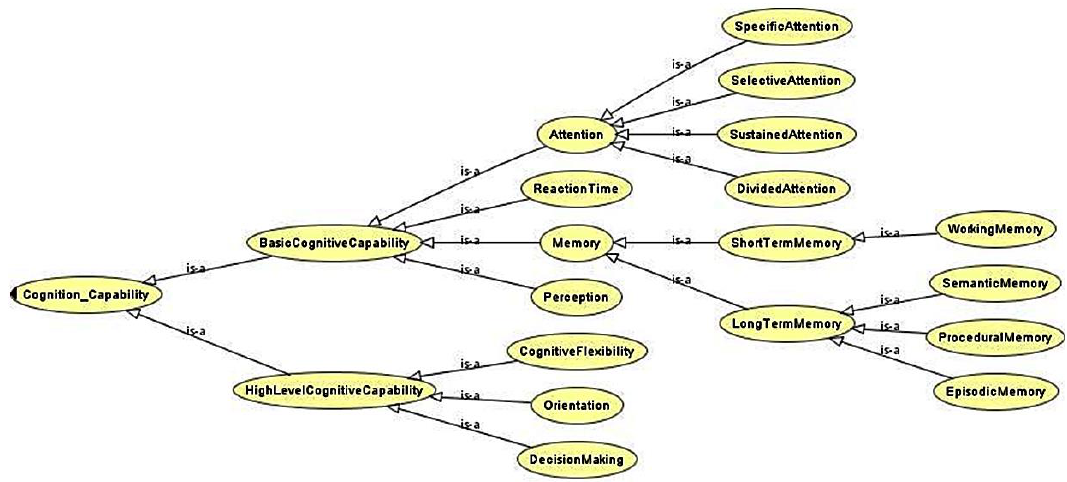
Figure 9. Cognitive capabilities affected by cognitive disabilities.